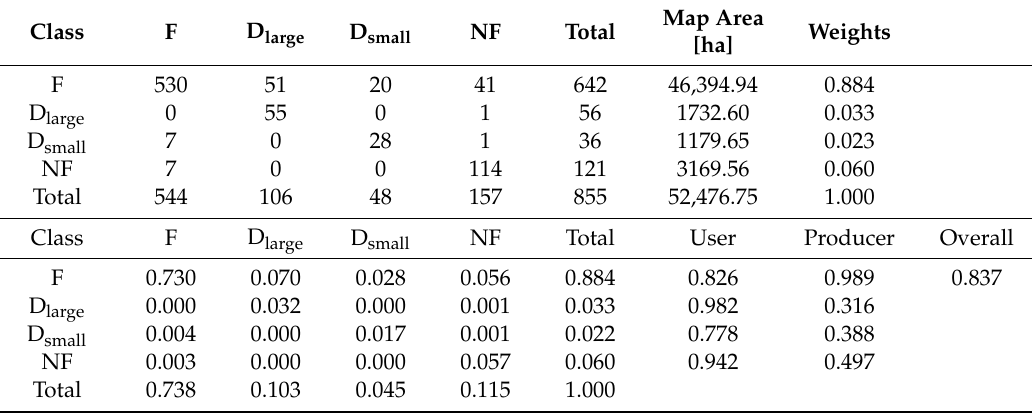
Table A9. “S1 Only” disturbance map validation Gabon.